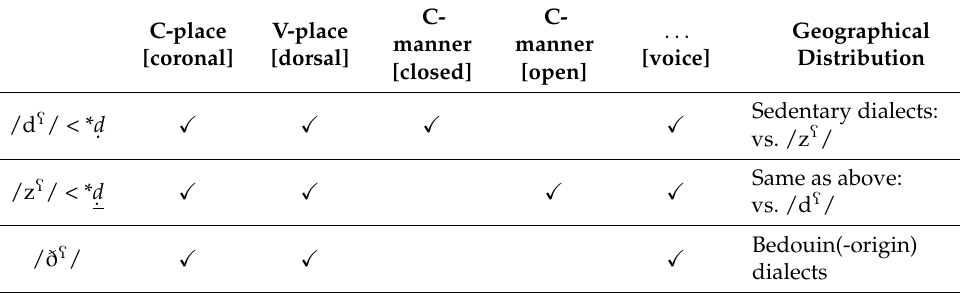
Table 5. Representational typology of * d. –* d. phoneme